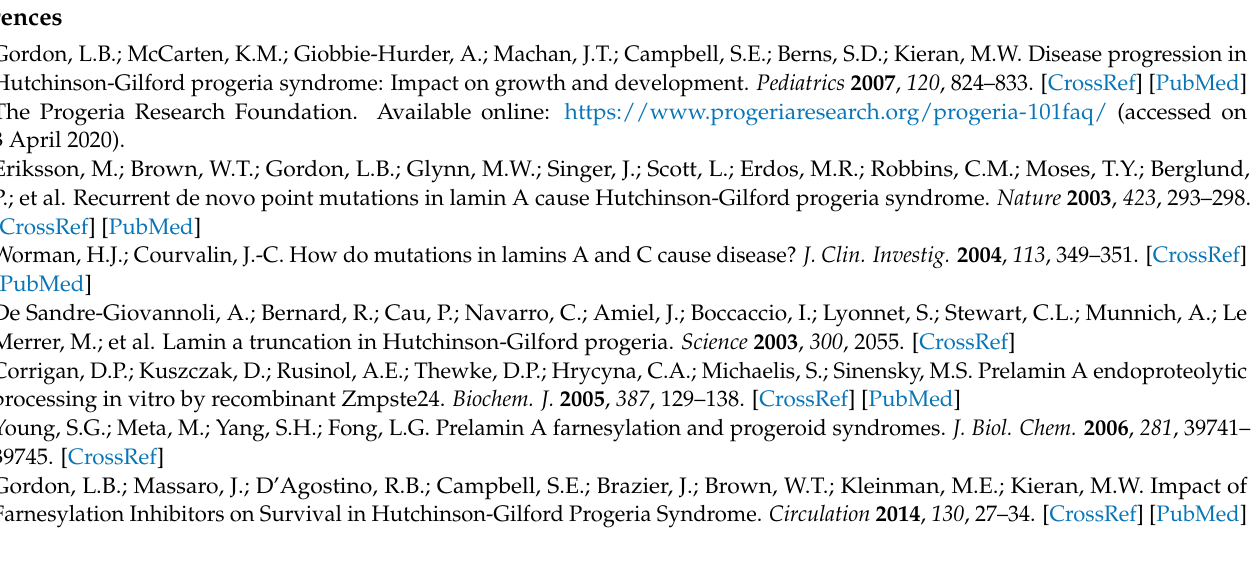
concentrations; Figure S2: Anit-p21-immunostaining in control fibroblasts after treatment with the different regi-mens; Figure S3: Progerin immunostaining in control fibroblasts after the different regimens; Figure S4: Proton leakage measurements; Figure S5: p-H2A.X immunostaining in control fibroblasts after treatments; Figure S6: Full-length scan of Western blots from Figures 2A,B and 3A; Table S1: Primers used for real-time PCR quantitative PCR